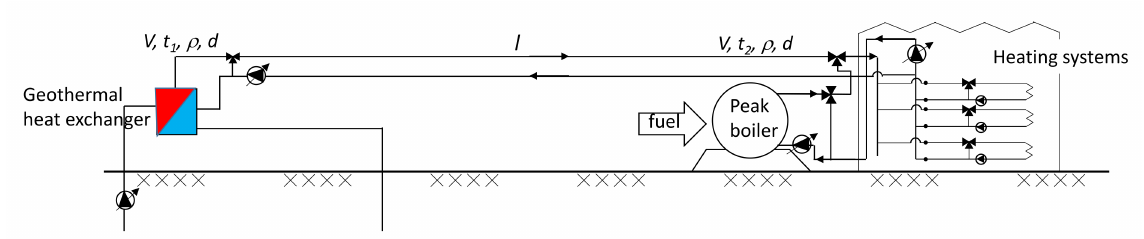
Figure 3. Scheme of a greenhouse heating system powered by a geothermal source and a peaking